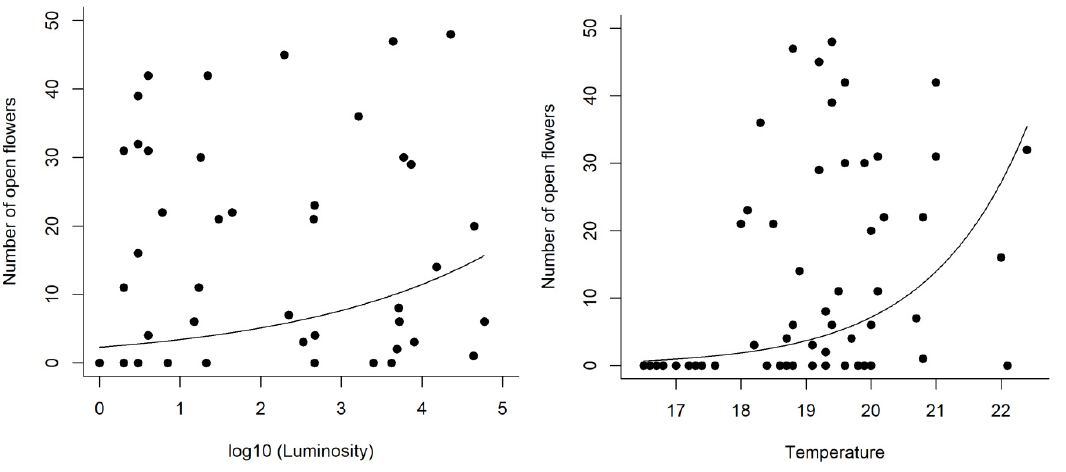
Fig 2. Effect of luminosity (the top) and temperature (the bottom) on the number of Ipomoea bahiensis open flowers. The predicted line is based on the best-fitted model using AIC.